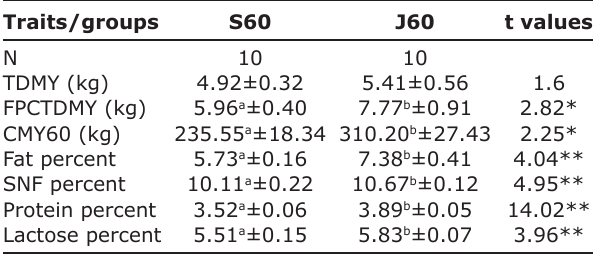
Table-1: Mean milk yield and composition traits of Surti and Jafarabadi buffaloes at day 60 th pp.